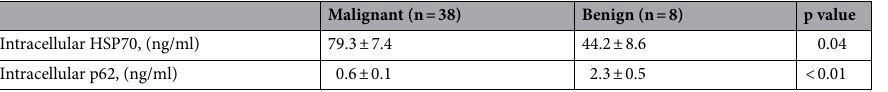
Table 3. Comparison of intracellular HSP70 and p62 in PBMCs from women with malignant or benign breast disease. Data are presented as mean ±